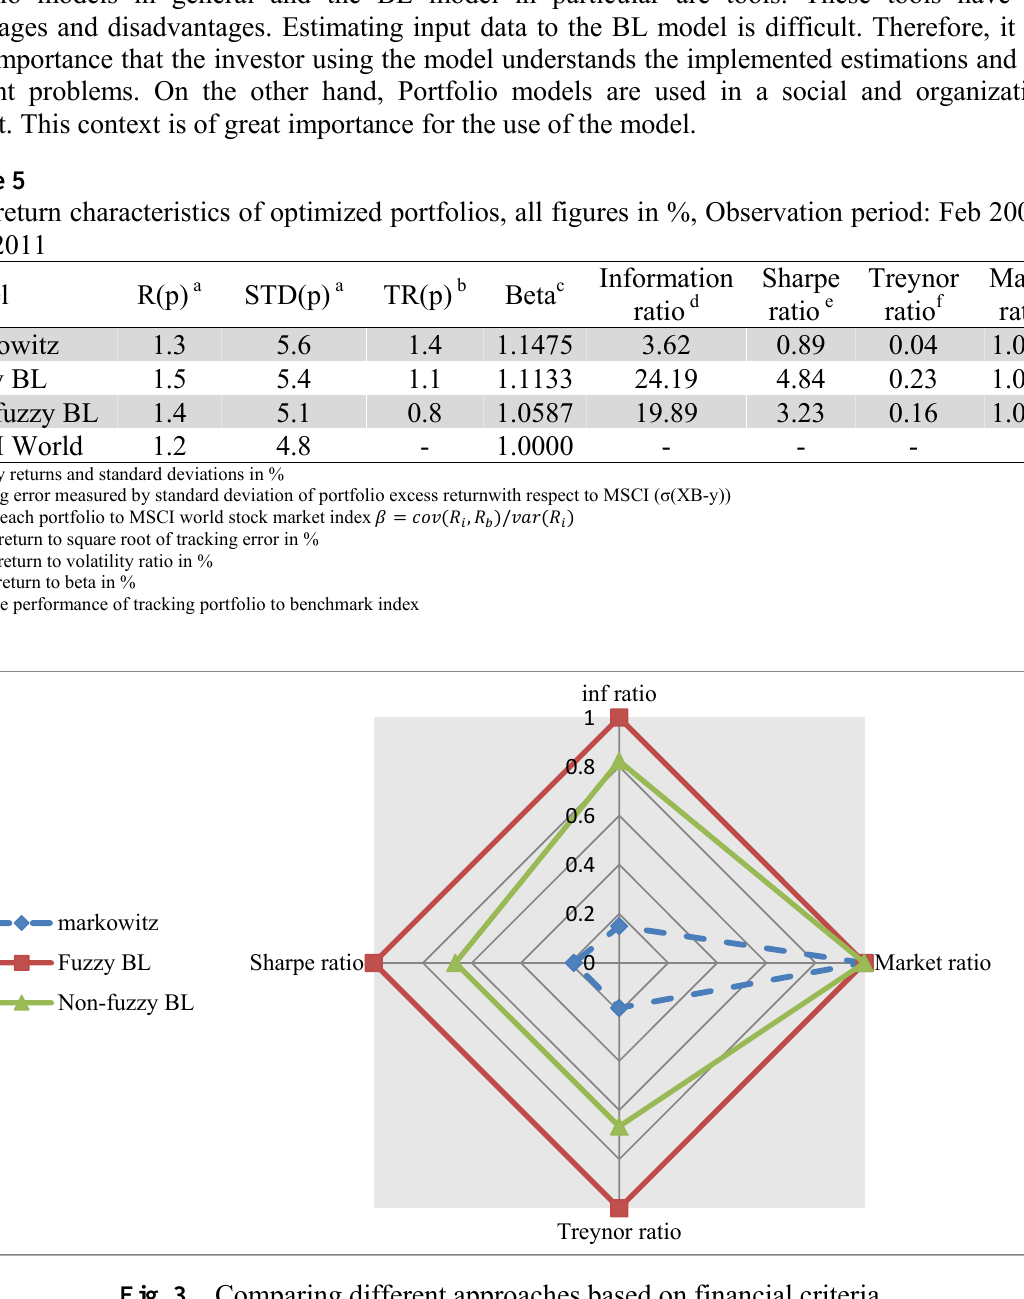
Fig. 3. Comparing different approaches based on financial